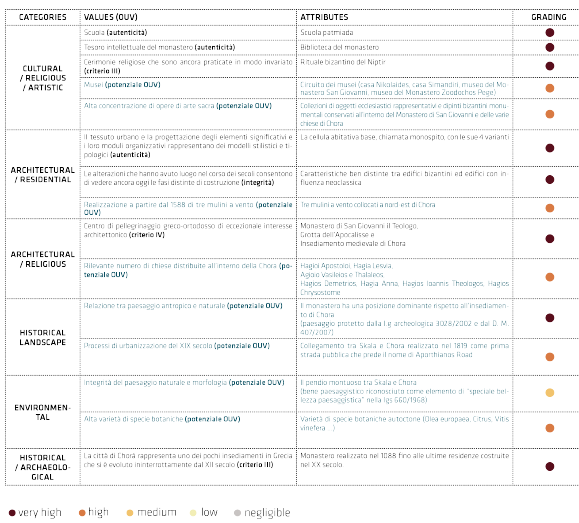
Figure 14. Exact from the table of the identification of attributes that convey OUV. Potential attributes are underlined in blue.